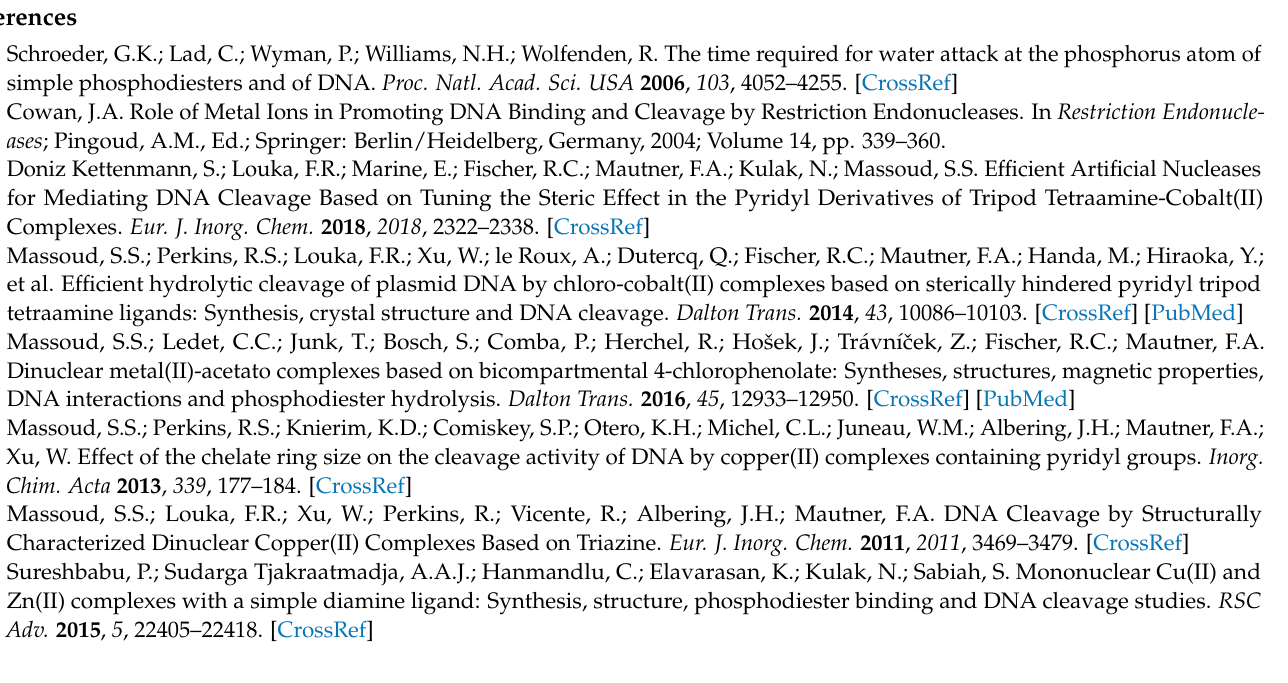
spectra of 1-Cl, 2-ClO 4 , 3-ClO 4 , and 5-Cl , respectively; Figure S10: Cleavage of pBR322 plasmid DNA by complexes; Figure S11: Cleavage of pBR322 plasmid DNA by complexes and ligands; Figure S12: UV-VIS spectra of BNPP (50 µ M) at pH = 7.4 in the absence and presence of phosphodiesterase; Figure S13 and Figure S14: UV-VIS spectra of BNPP (270 µ M) at pH 7.4 in the presence of Cu(II) complexes after 2 and 96 h, incubation; Figure S15: Fluorescence spectra of TPA and PBSF after incubation with/without [Cu(L 1 )ClO 4 ]ClO 4 ( 1 - ClO 4 ); and Figure S16: Results of the MTT assay in in the online